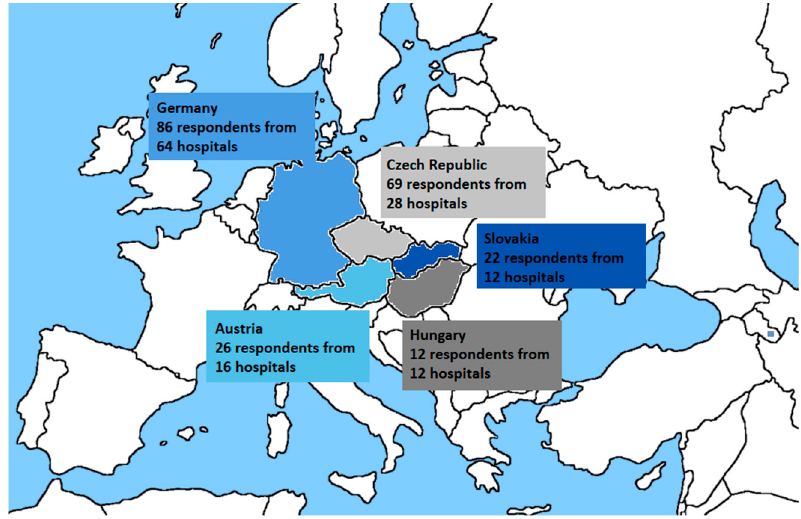
Figure 1. Regions analyzed: numbers of hospitals and respondents participating in the research.